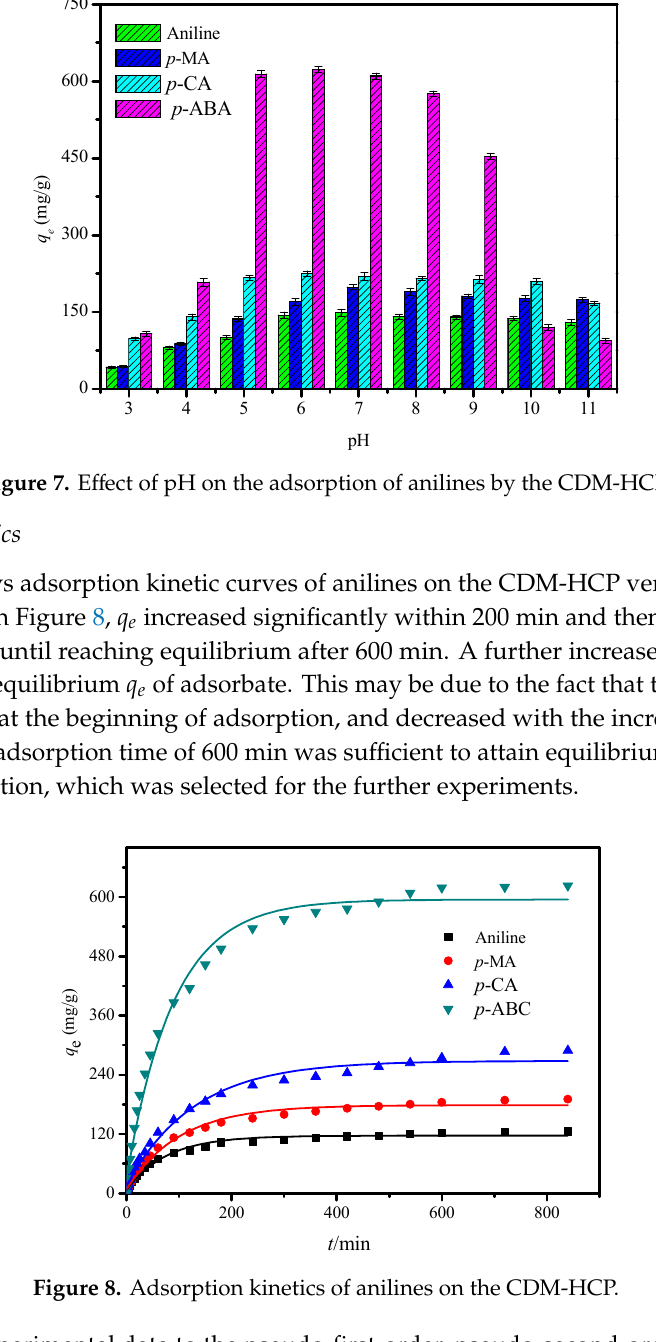
Table 1. Kinetic parameters for the adsorption of aniline compounds on the CDM-HCP at 20 °C. Model Parameter